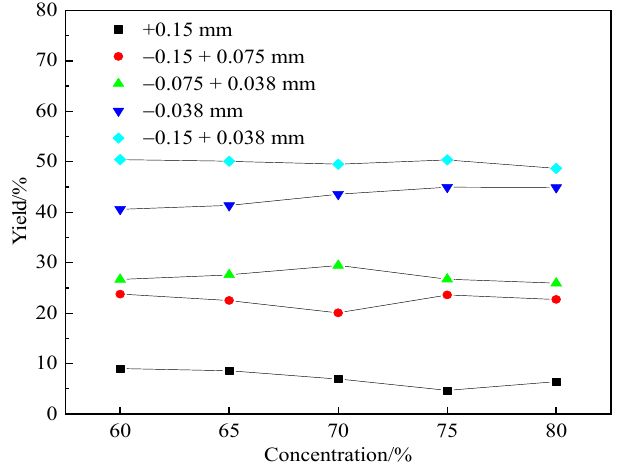
Figure 6. Particle size of grinding product at different grinding concentrations.